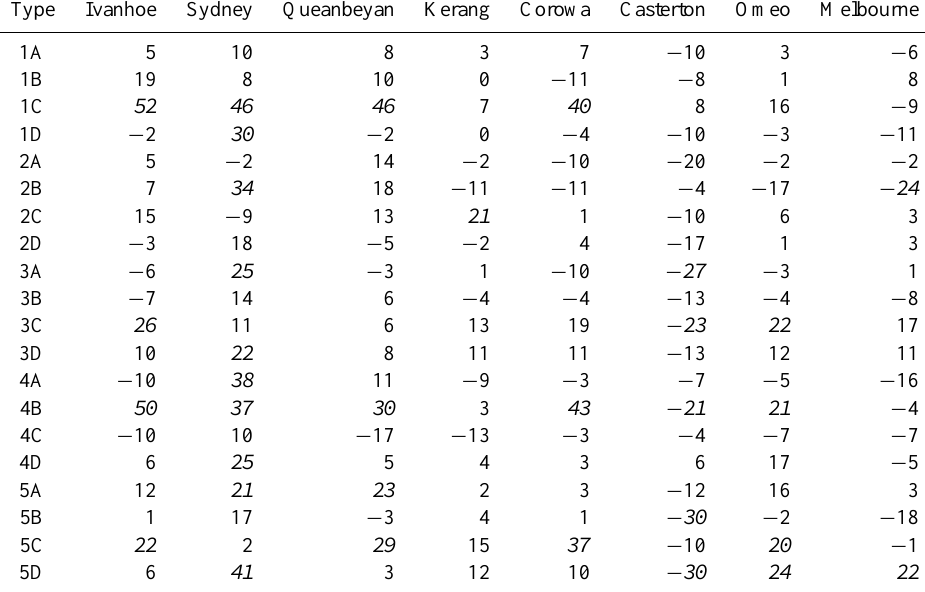
Table 1. Percentage change in the likelihood of a rain day (greater than 1mm) for a given synoptic type during the autumns of 1988–1990 compared to the 1948–2009 period (substantial deviations from the long-term mean ( > 20% or < − 20%) are highlighted in italic).